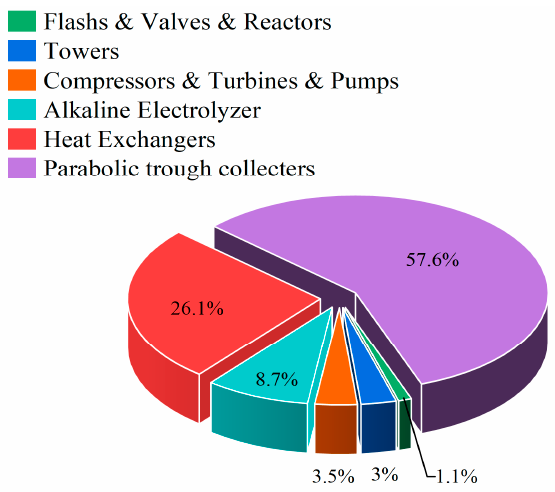
Figure 6. The exergy flow of the proposed green poly-generation integrated system.